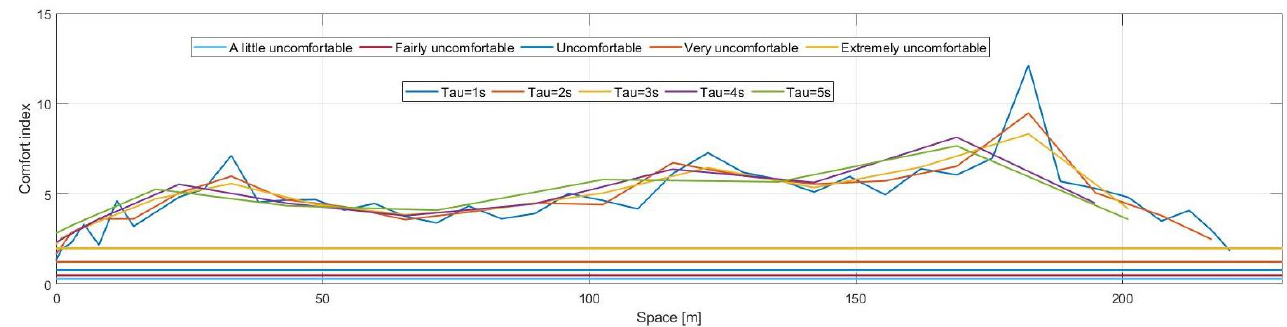
Figure 11. Comfort index for different RMS time steps.